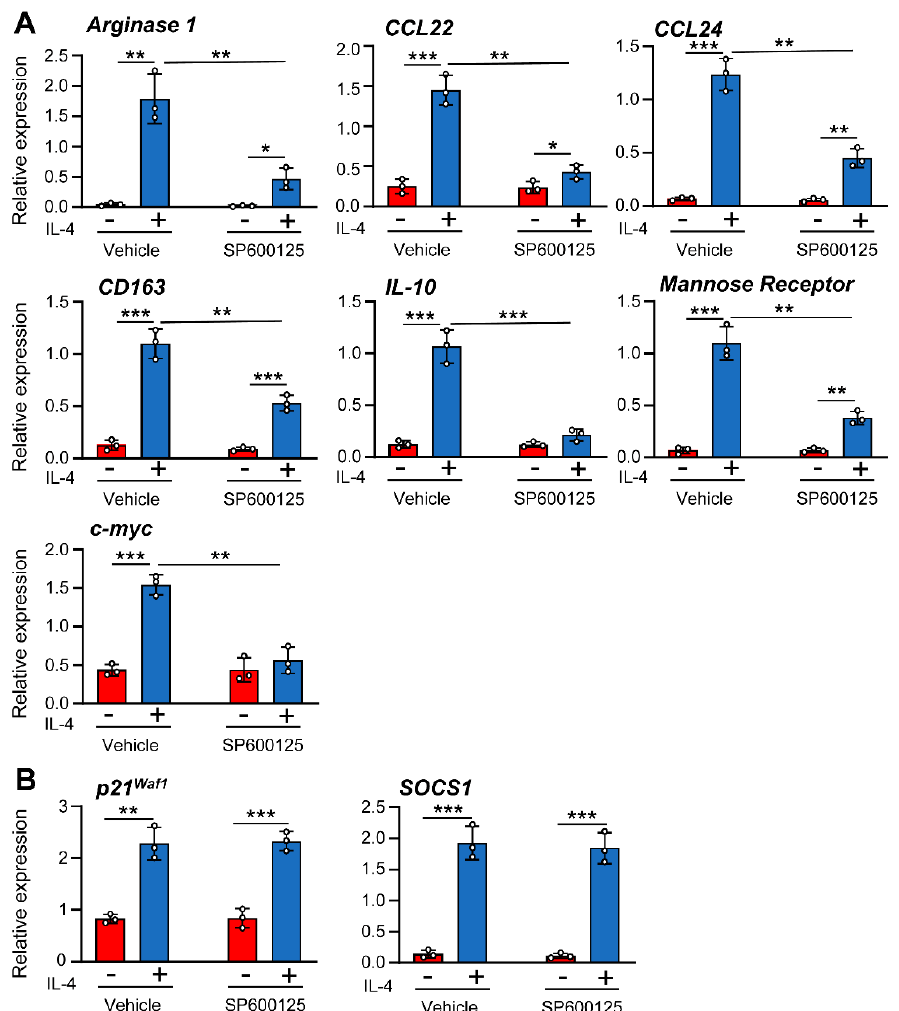
Figure 3. ( A , B ) Different effects of JNK-1 on IL-4-induced gene expression. Macrophages were pre-incubated for 1 h with the JNK inhibitor SP600125 (5 µ M) or vehicle (DMSO) as a control. The cells were then stimulated for 6 h with IL-4 except when gene expression of SOCS1 (3 h) and c-myc and p21 Waf1 (1 h) were analyzed by qPCR. The results are shown as the mean ± SD of 3 independent experiments. * p < 0.05, ** p < 0.01, and *** p < 0.001 in relation to the corresponding treatments after all the independent experiments had been compared. Data were analyzed using Student’s t